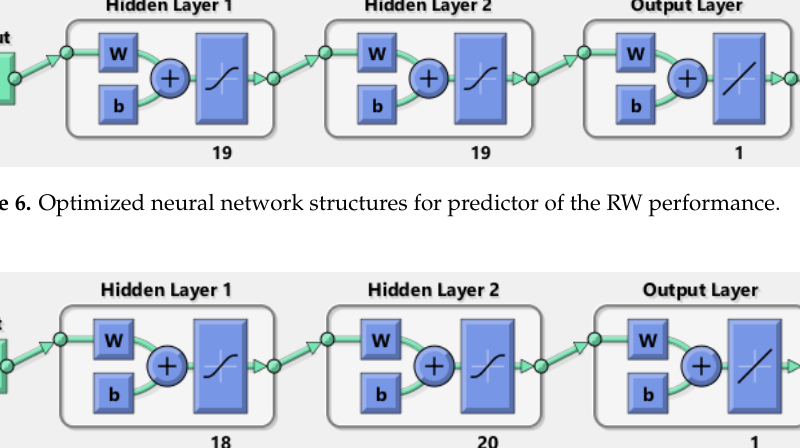
Table 2. Results for prediction of the RW and RW_WSB performance.